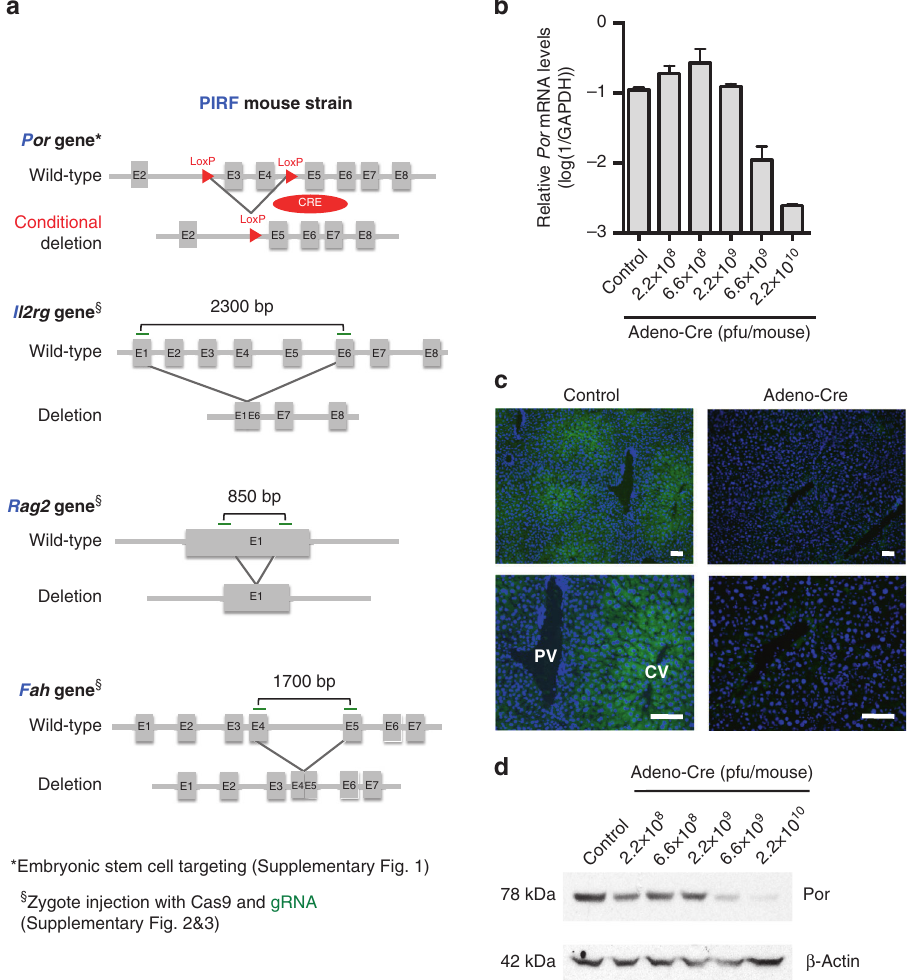
Fig. 1 Generation of the PIRF strain and deletion of the murine P450 ( Por ) oxidoreductase. a Schematic representation of deleted and transgenic loci in the PIRF strain. b qPCR of Por mRNA 7 days after intravenous injection of adenovirus expressing the CRE recombinase (Adeno-Cre). c Immunostaining for Por protein demonstrating a gradient across the hepatic acinus with higher pericentral (cv) and lower periportal (pv) expression. Seven days after injection with Adeno-Cre, Por is barely detectable. d Western blotting con fi rms almost complete disappearance of Por protein 7 days after injection. Results are expressed in mean values ± s.e.m. of triplicates ( N = 3). Scale bar 50 μ m. PIRF, Por c/c /Il2rg − / − /Rag2 − / − /Fah − /